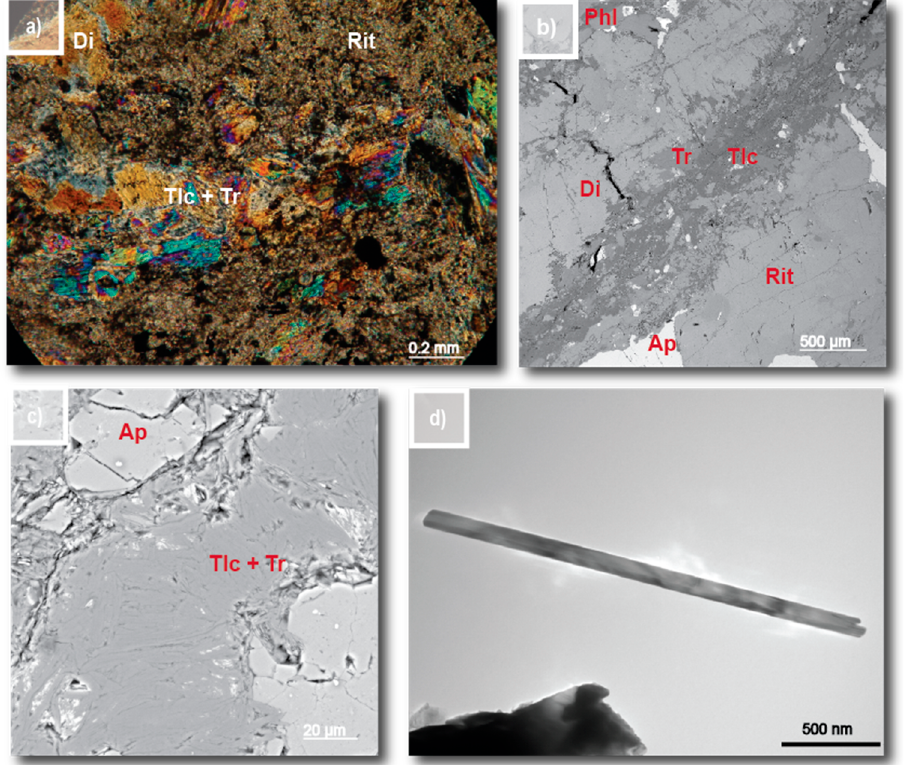
Figure 8. Sample 4 (S4). ( a ) Photomicrograph of the pyroxenite cut by a talc and tremolite vein;